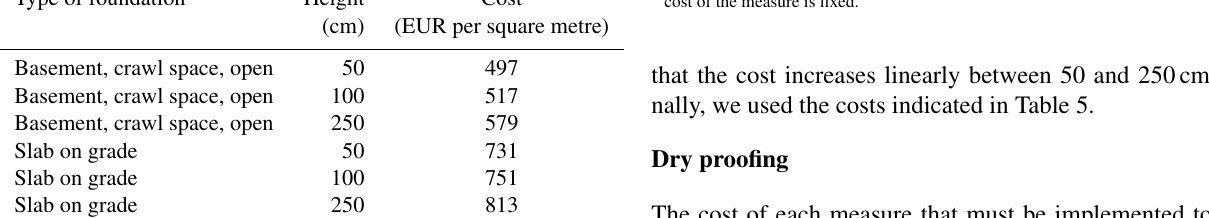
Table 5. Costs of elevating a masonry dwelling used in our study. Type of foundation Height